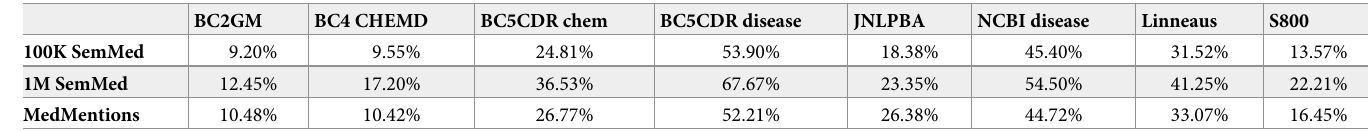
Table 3. Percent of unique entities in our NER datasets that also appear at least once as labeled entities in each of our pre-training